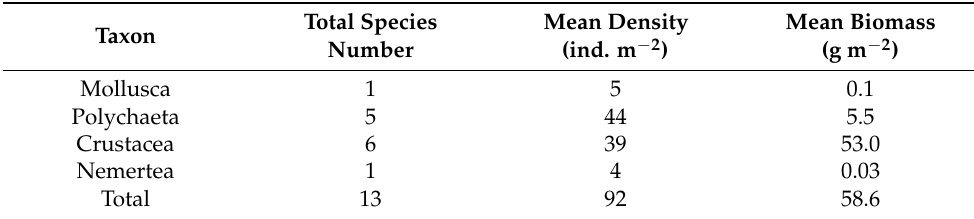
Table 3. Information on the macrobenthic species community collected from the tidal flat of Yubu Island in the western coastal area of South